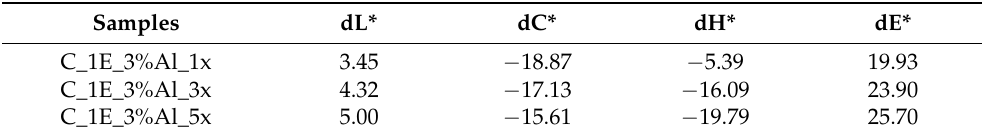
Table 9. Change in color coordinates of cotton samples dyed with SJL aqueous extract with 3% Al mordants after 1st, 3rd and 5th washing cycle (compared with C_1E_3%Al_0x). Samples